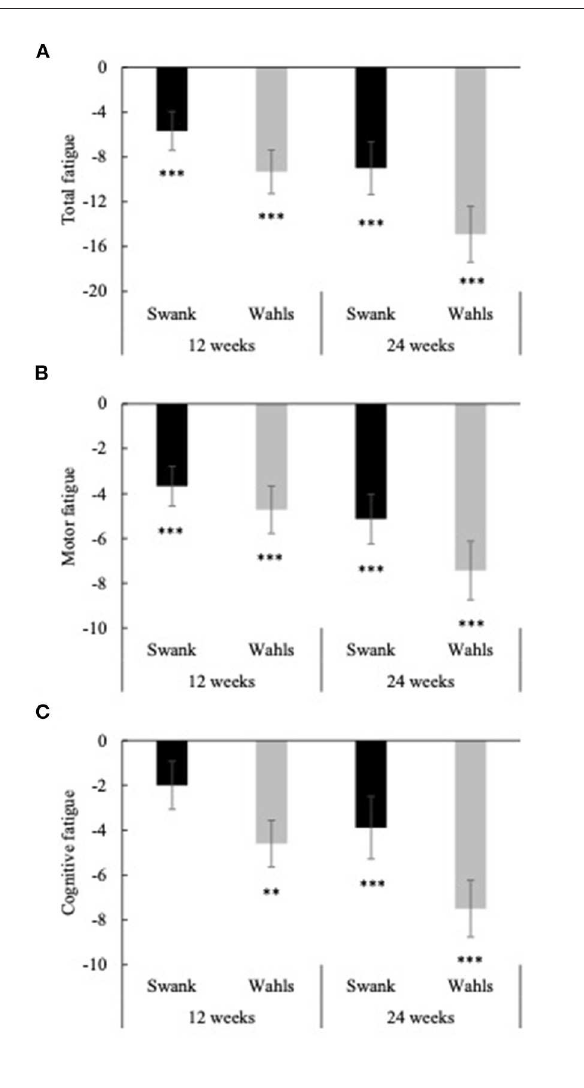
FIGURE5 Mean change from baseline for (A) total fatigue, (B) cognitive fatigue, and (C) motor fatigue as determined by the fatigue scale for motor and cognitive functions (FSMC) at 12- and 24-weeks for the Swank (black bars) and Wahls (gray bars) groups. Statistical significance was determined by generalized linear mixed models and represented by * p ≤ 0.05 and *** p ≤